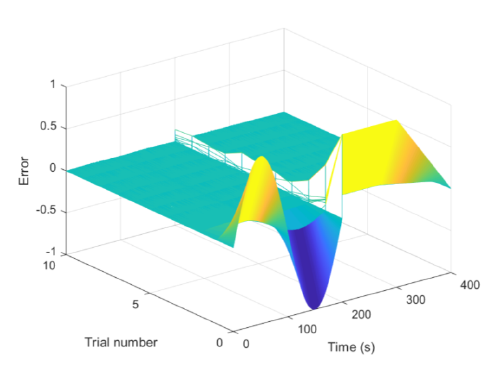
Figure 4. Surface of tracking error of polyhedron uncertainty system varying with time and iteration times.